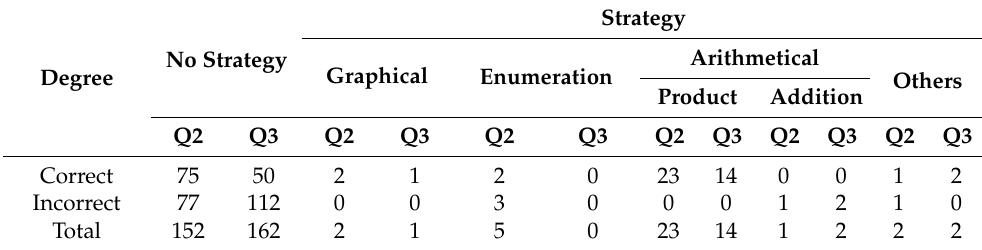
Table 5. Degree-strategy frequencies of Q2 and